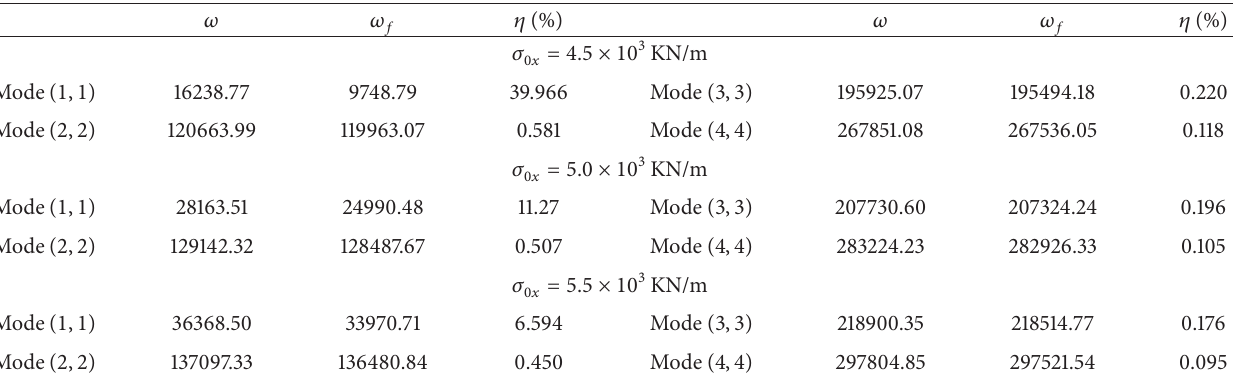
Table 3: Natural frequency of the micro pressure sensor for various initial tension stresses